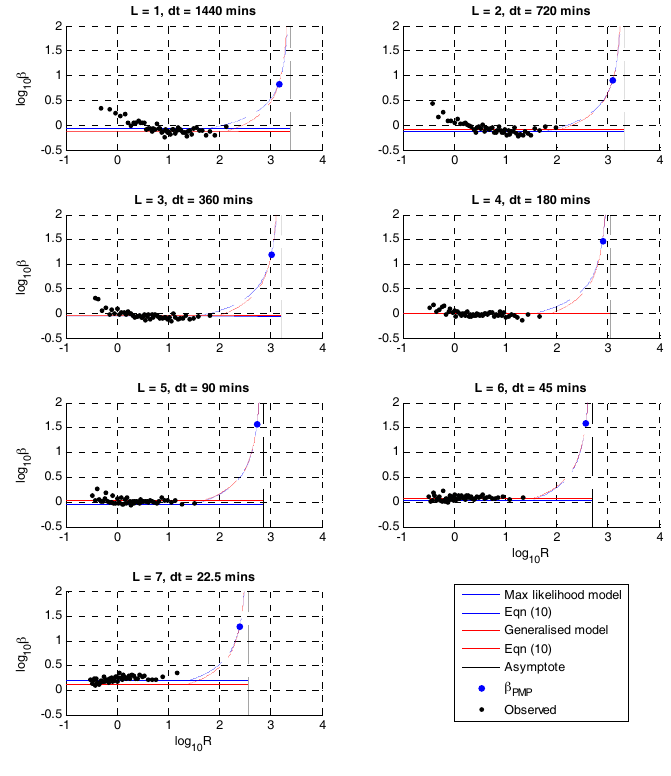
Figure 4. Volume dependence of parameter β .